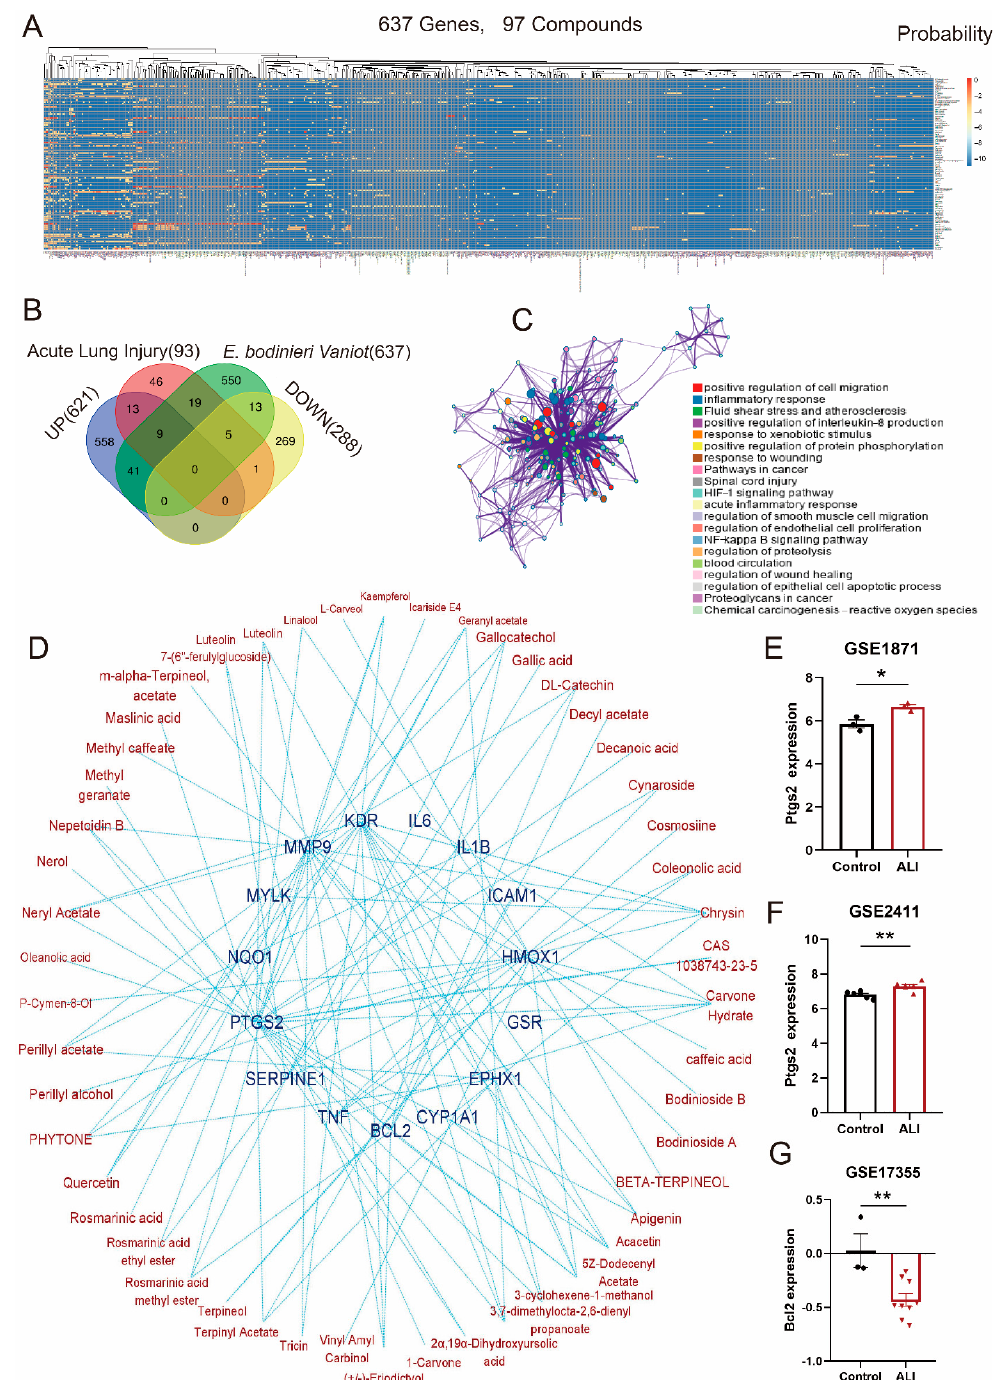
Figure 3. Exploration and identification of key genes in ALI regulated by E. bodinieri Vaniot. ( A ) Heat map illustrating the probability between ALI genes and compounds of E. bodinieri Vaniot. ( B ) Venn diagram of hub genes in upregulated genes, ALI-related genes, potential target genes of E. bodinieri Vaniot, and downregulated genes. ( C ) GO network of hub genes was constructed by Metascape database, and Cytoscape software. ( D ) Key genes-compounds network. The blue nodes represent the key genes, the brown nodes represent the compounds, and the edges represent the interactions between them. ( E ) The expression of Ptgs2 in GSE1871 dataset, n = 3. ( F ) The expression of Ptgs2 in GSE2411 dataset, n = 6. ( G ) The expression of Bcl2 in GSE17355 dataset, control n = 3, ALI n = 9. Data are presented as mean ± SEM, * p < 0.05, ** p <